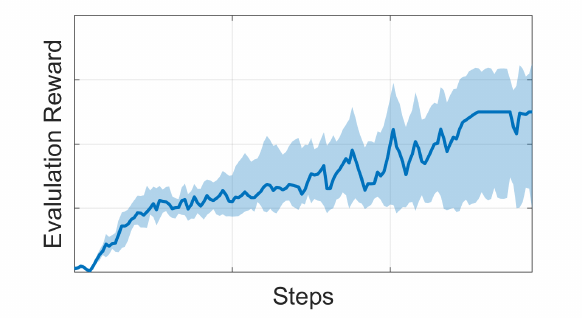
Figure 8. Sample performance plot of an RL